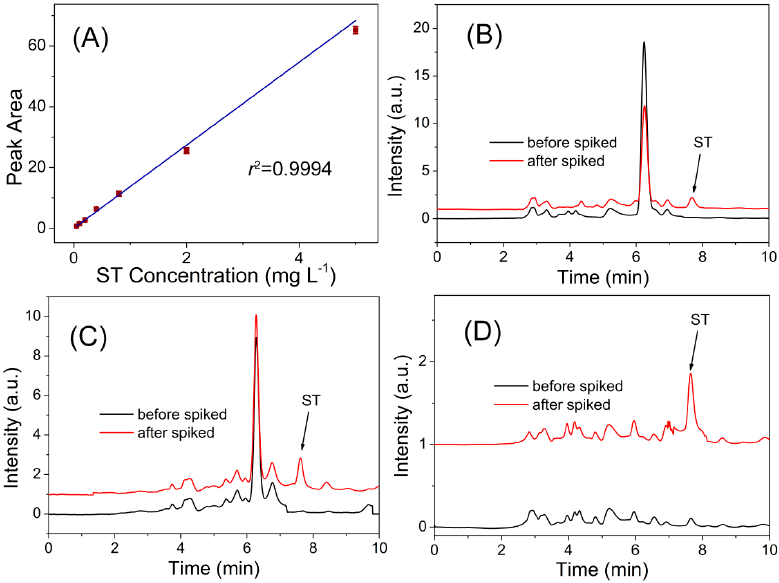
Figure 6. ( A ) The linear response of the developed MIP-HPLC method to ST. ( B – D ) Chromatograms of blank sample (black line) and spiked with 50.0 ug·kg − 1 ST (red line) for analyses of: wheat ( B ); rice ( C ); and millet ( D ). Table 3. Application of the developed MIP-HPLC method for the determination of ST in real samples. Samples Spiked Samples